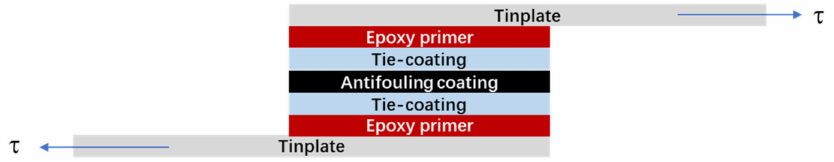
Figure 3. Schematic of the shear